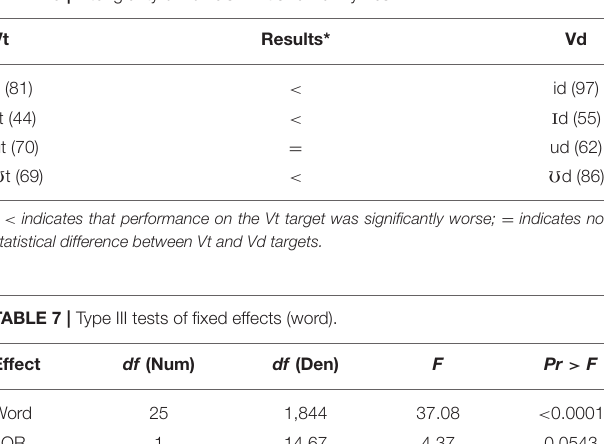
TABLE 4 | Type III tests of fixed effects (rhyme).